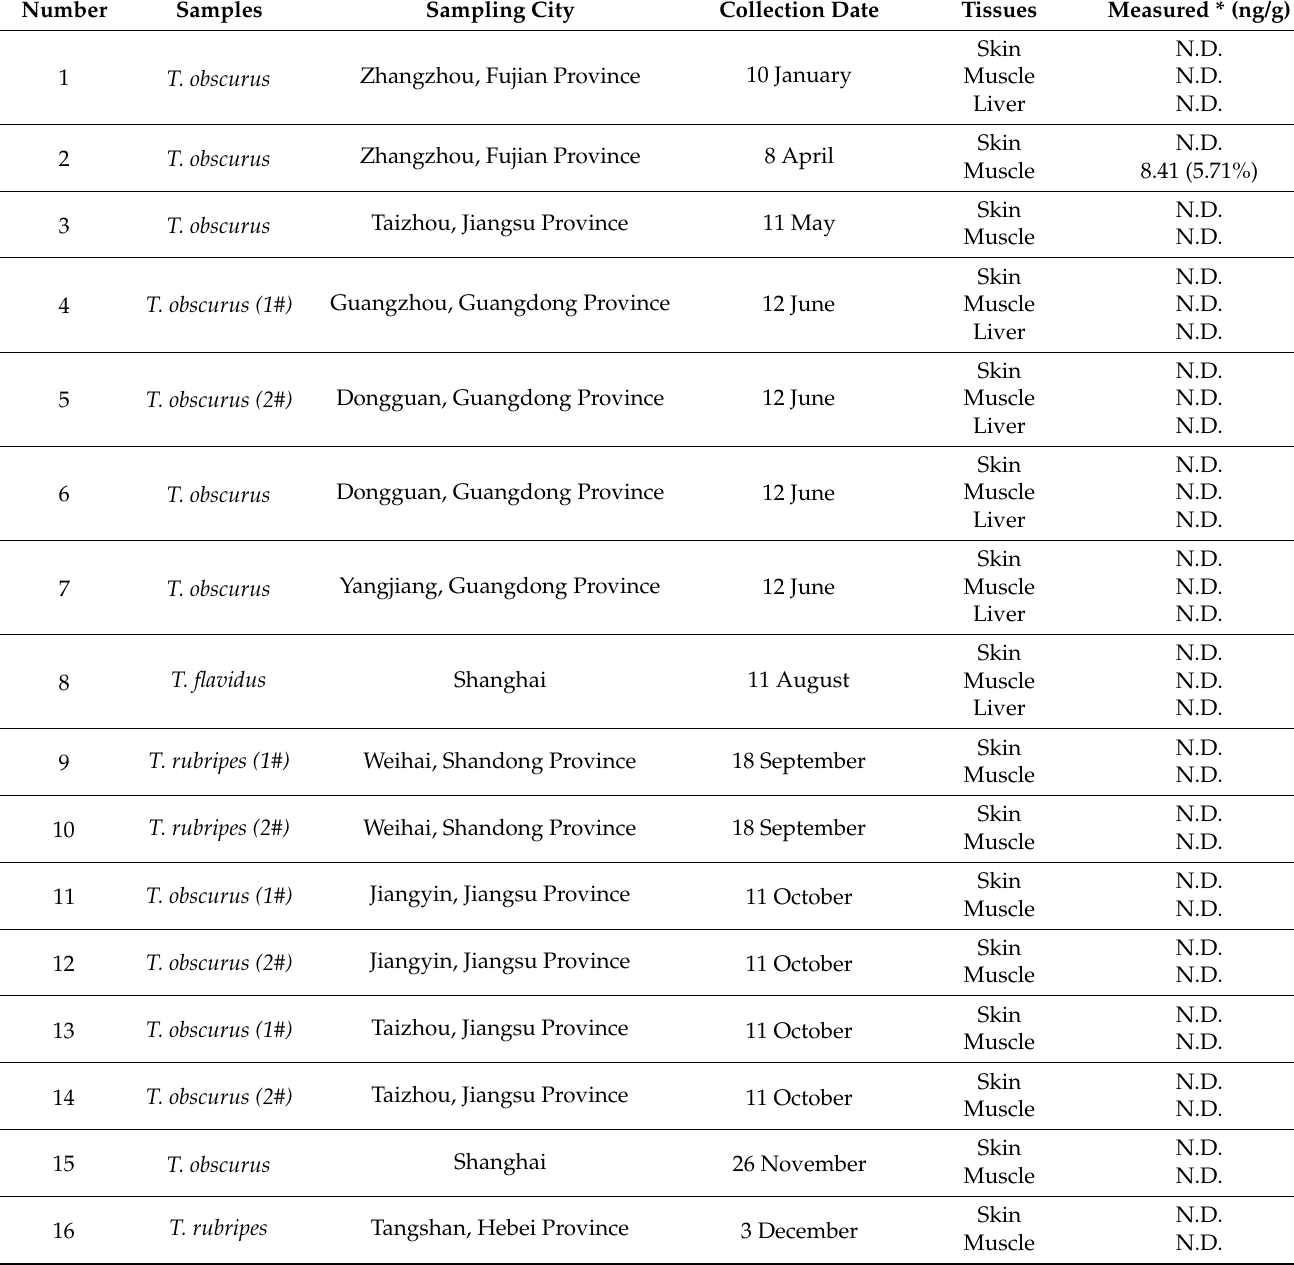
Table 5. Determination of TTX in different fresh pufferfishes and heat-processed fish based on the established